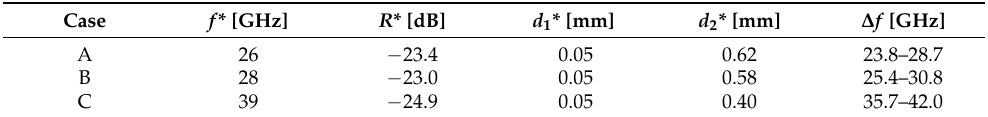
Table 3. Optimal thicknesses, lower minimum reflection coefficient and bandwidths at − 10 dB for composite filled with 4% of GNPs at target frequencies in case of normal incidence.